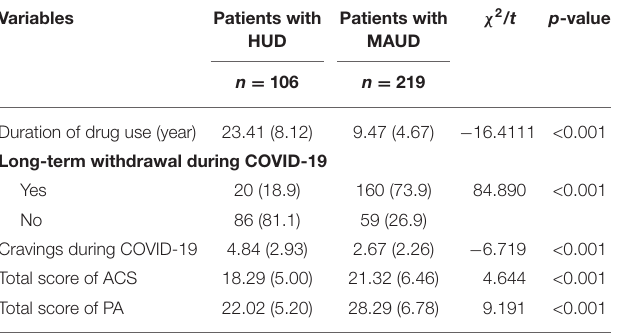
TABLE 2 | Clinical variables of patients with HUD and patients with MAUD. Variables